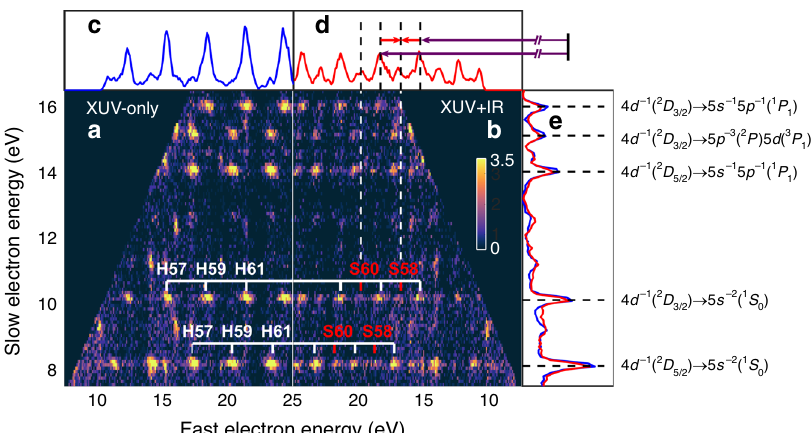
Fig. 2 Two-electron coincidence map. The coincidence map using a XUV fi eld only and b XUV + IR fi elds. The number of measured two-electron pairs is indicated by the color code. The spots with constant slow-electron energy and variable fast-electron energy correspond to photoelectrons created by absorption of consecutive harmonics (labeled as H57-H61 in (a) as an example) and a given Auger electron (e.g., 4 d − 1 ( 2 D 3/2 ) → 5 s − 2 ( 1 S 0 )). Photoelectrons corresponding to absorption or emission of an additional IR photon (sidebands, labeled as S58 and S60 as an example) appear in b . The projection on the fast electron energy axis c and d is the sum of the signal with slow electron energy from 10 eV to 10.4eV, i.e., the photoelectrons in coincidence with 4 d − 1 ( 2 D 3/2 ) → 5 s − 2 ( 1 S 0 ) Auger electrons. The projection on the slow electron energy axis e shows the sum of the signal for the different Auger processes indicated on the right, with (red) and without (blue) IR fi eld. A RABBIT energy scheme is indicated at the top of d .